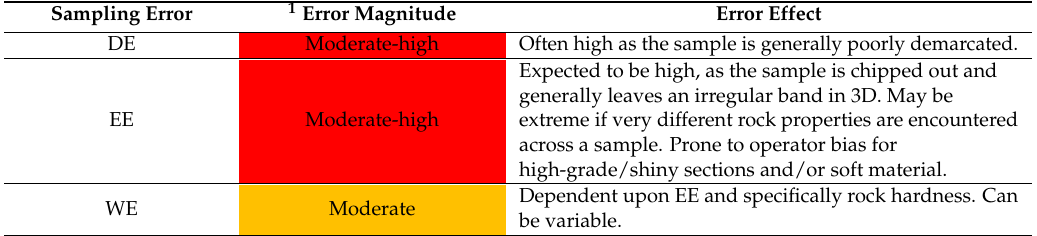
Figure 3. Orientation of linear samples (e.g., chip-channel) to match geological requirements. Sub-vertical quartz reef in foreground with area of flat veining on the footwall (blue line marks footwall contact). Sub-vertical reef sampled horizontally (samples 1 and 7), whereas flat footwall veins sampled vertically (samples 2–6). Table 8. Likely sampling errors during the collection of chip or chip-channel samples.